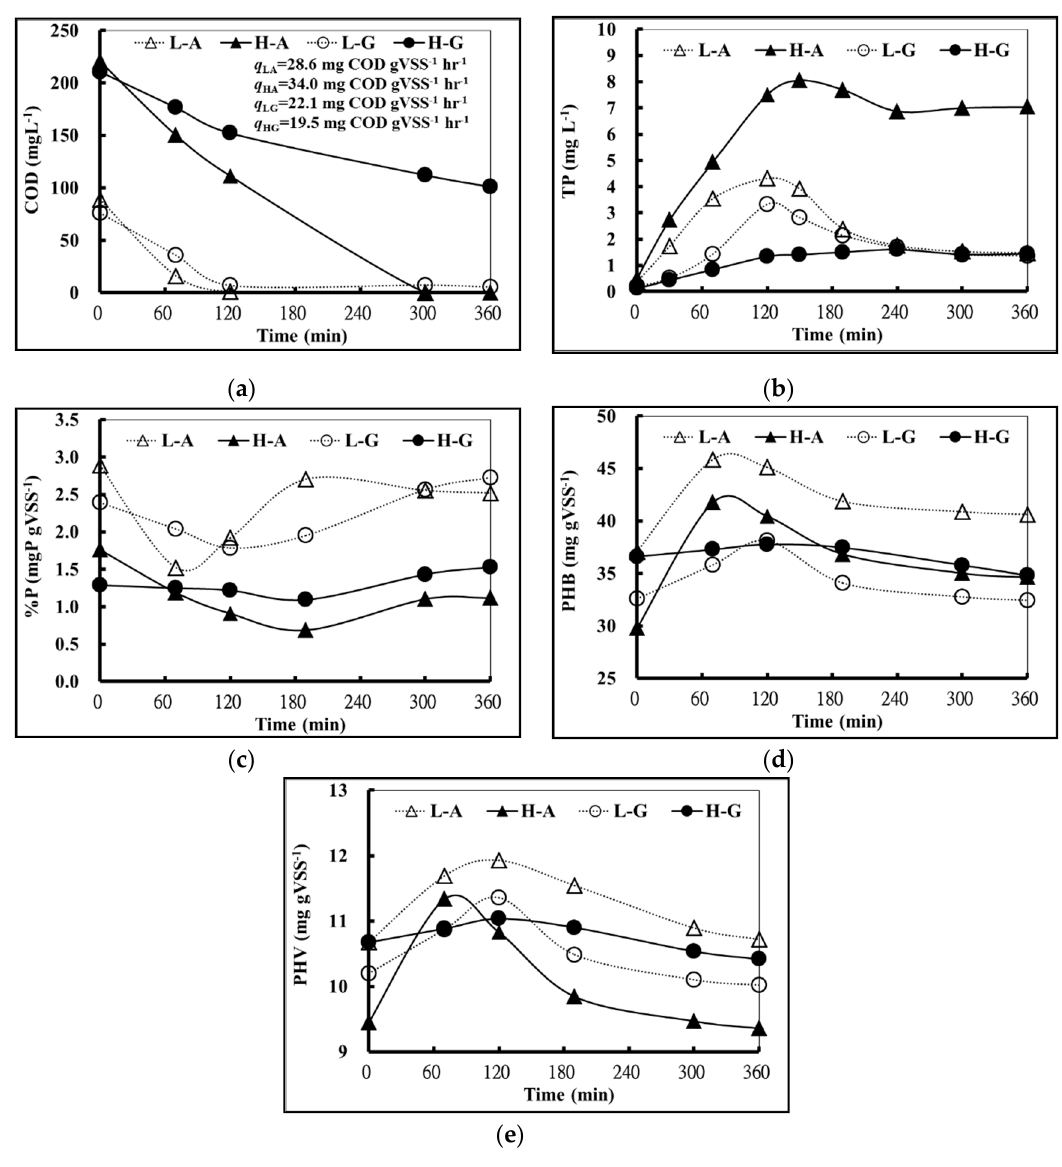
Figure 2. ( a ) COD; ( b ) total phosphorus (TP); ( c ) P%; ( d ) poly-b-hydroxybutyrate (PHB); and ( e ) poly-b-hydroxyvalerate (PHV) in 360 min. (L-A: low concentration acetic acid, H-A: high concentration acetic acid, L-G: low concentration glucose, H-G: high concentration glucose ).